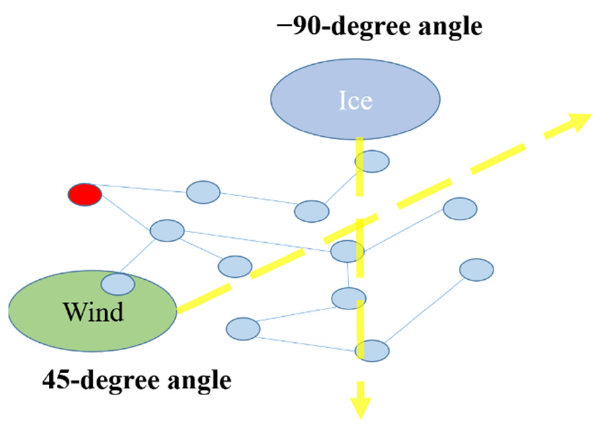
Figure 16. Ice and Wind started sites in the topological model. Table 4. Load of wind and ice of highest 8 lines in IEEE-30 during this process. Number of Lines (Wind) Load of Wind